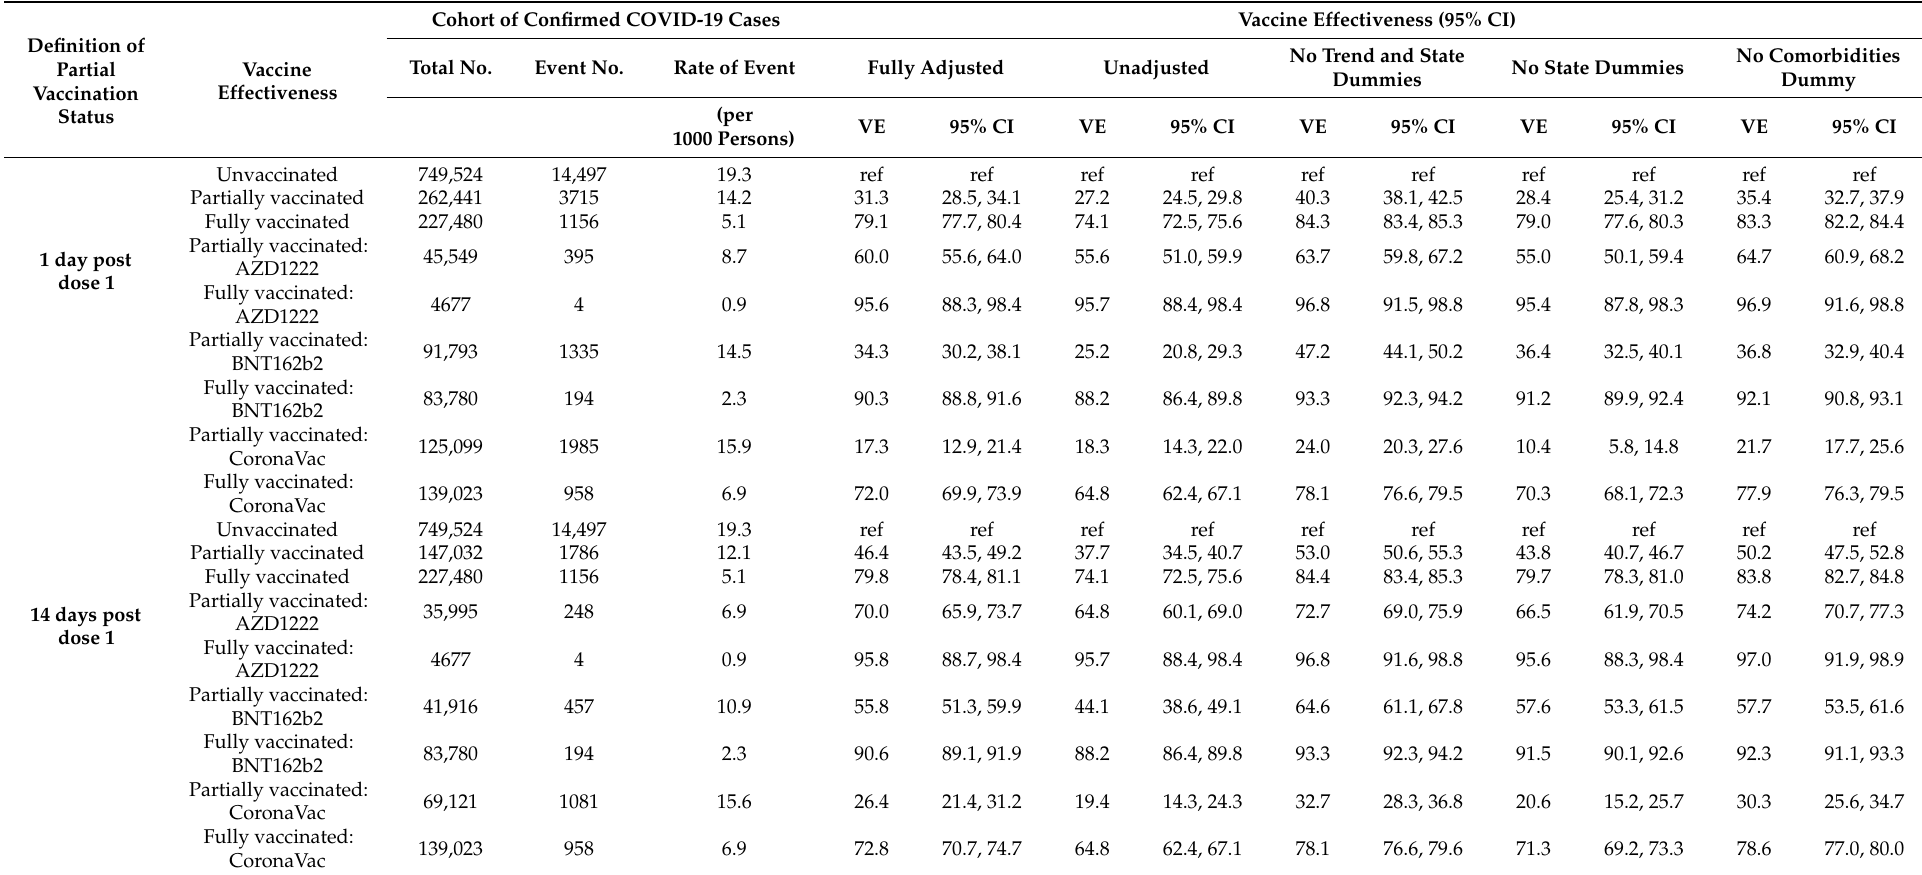
Table A6. Fully adjusted, partially adjusted, and unadjusted vaccine effectiveness in preventing admission to ICU among COVID-19 cases by definitions of partial vaccination status. Definition of